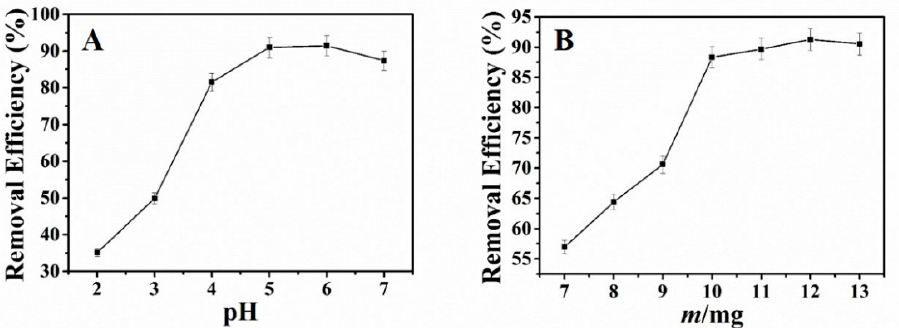
Figure 3. Effect of pH ( A ) and adsorbent dosage ( B ) on adsorption of Pb 2+ (initial content of Pb 2+ : 25 mL 30 mg · L − 1 ; time: 3 h; temperature: ambient temperature).